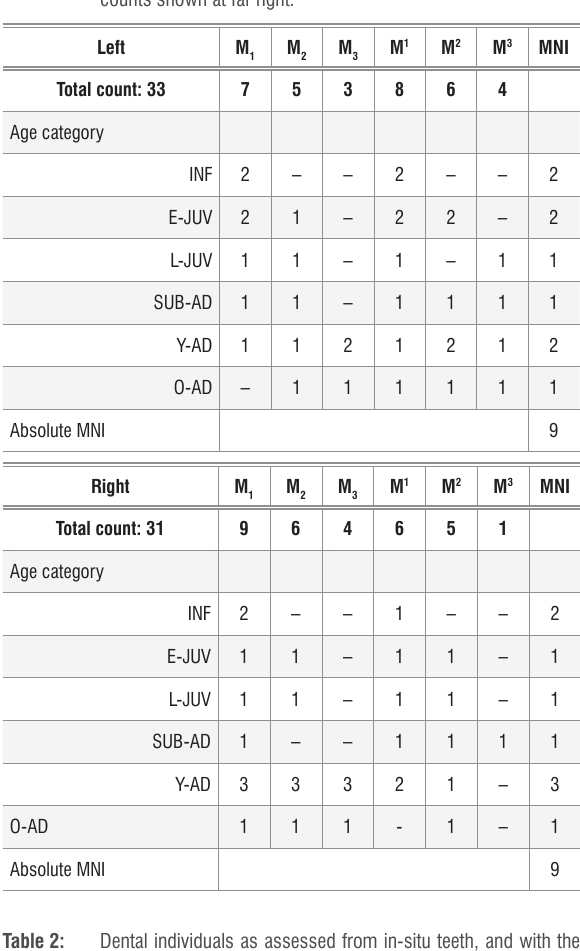
Table 1: Count of 64 permanent molars, roots and germs, separated by left and right sides, divided into age classes. Absolute minimum number of individuals (MNI) based solely on molar counts shown at far right.